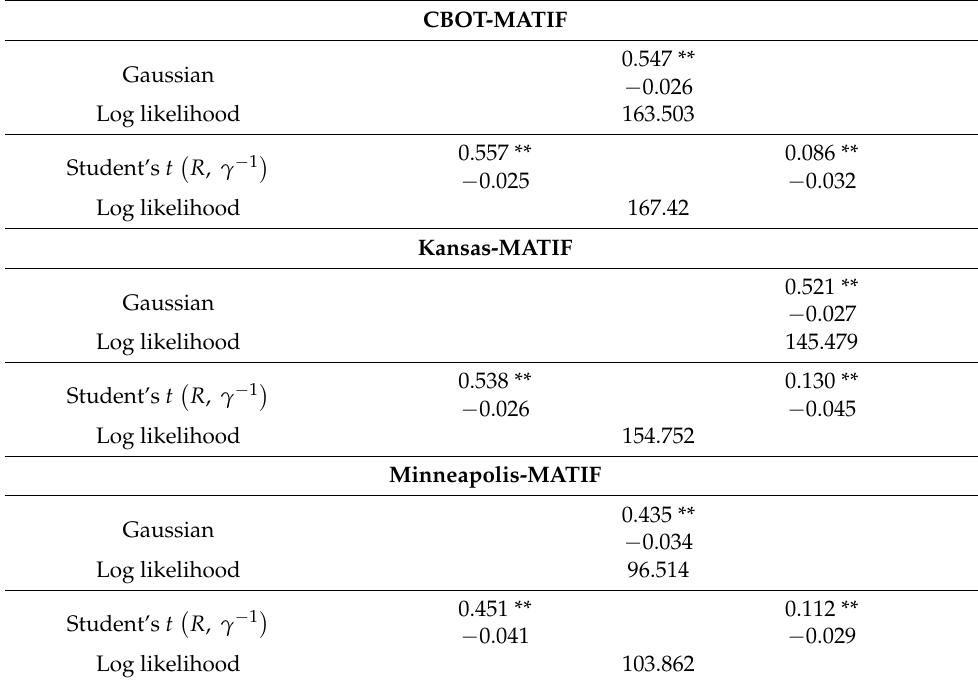
Table 11. Results from static copulas for the third period